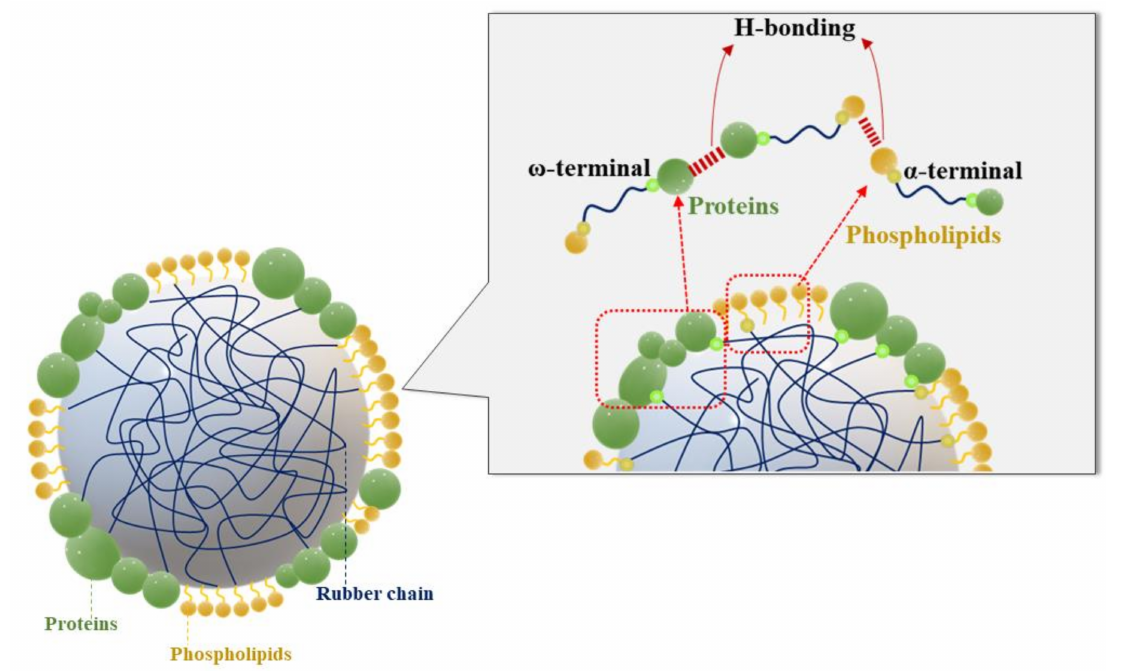
Figure 5. Schematic representation of α - and ω -terminal groups on the rubber latex particle